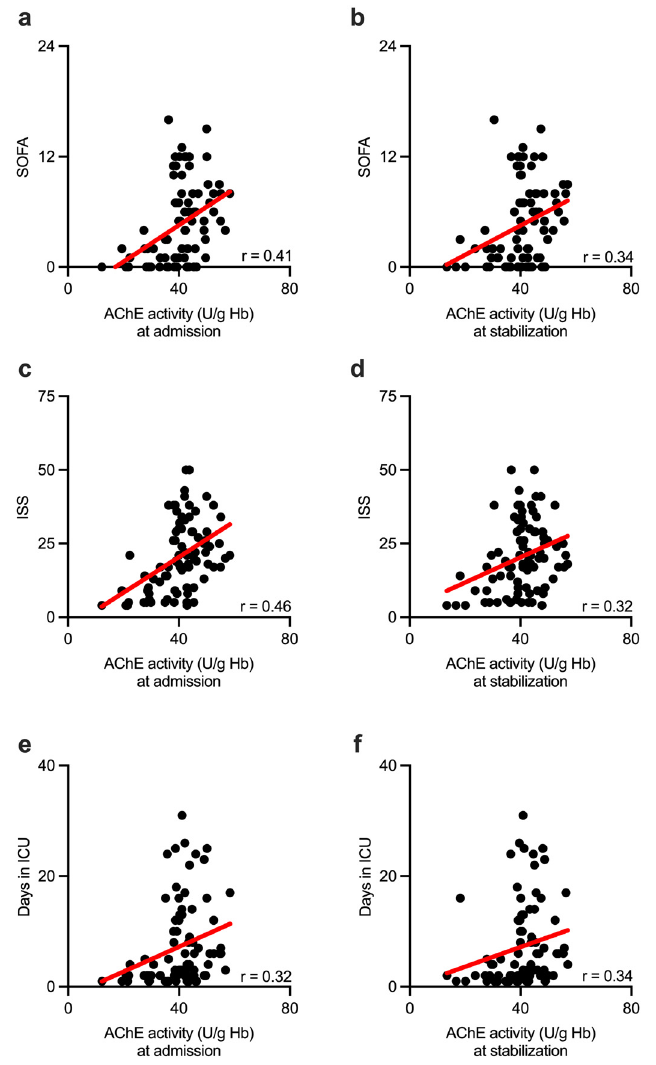
Figure 6. AChE activity correlated with the disease severity scores and the length of the ICU stay throughout the early period of the sterile inflammation. AChE activity was measured at hospital admission ( a ) and at the stabilization time point, 4–12 h following hospital admission ( b ), correlated with SOFA score obtained from injured patients 24 h following hospital admission. AChE activity was measured at hospital admission ( c ) and, following the stabilization ( d ), correlated with the ISS score obtained from injured patients. Initially measured AChE activity ( e ), as well as AChE activity obtained during the stabilization phase ( f ), correlated with the length of ICU stay of injured patients.